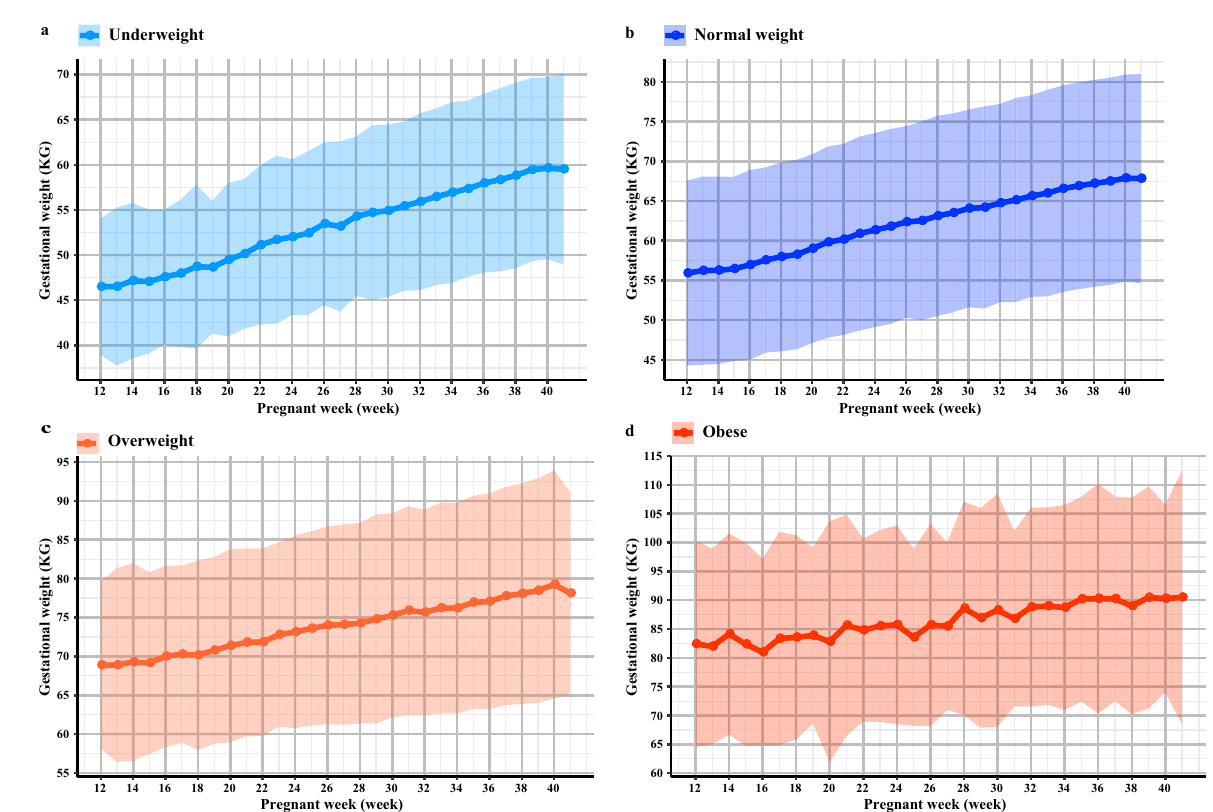
Figure 1. The GWG trajectory among Chinese women with GDM. ( a–d ) The GWG trajectory from 12th gestational week to 40th gestational week in underweight, normal weight, overweight and obesity group were shown,